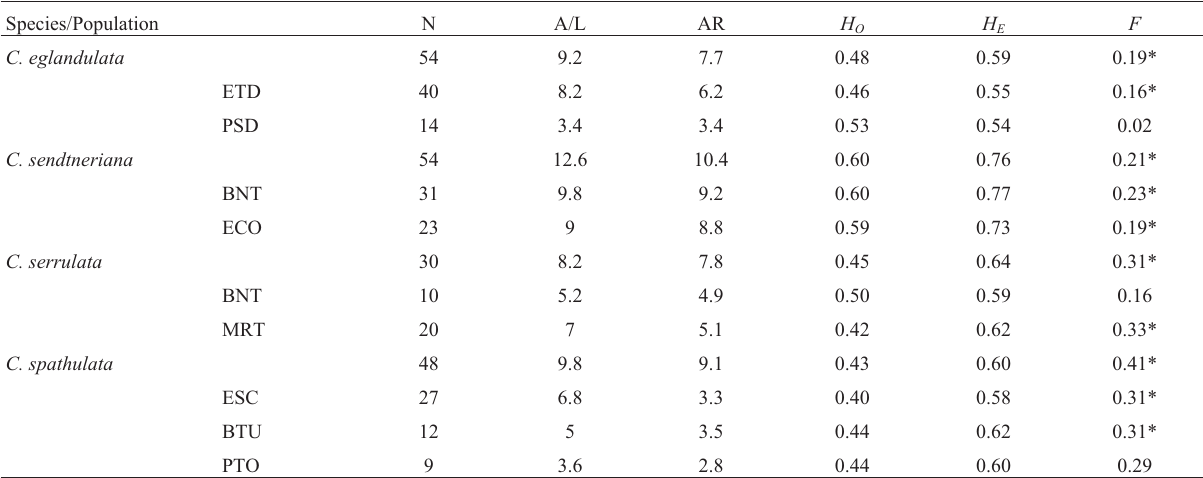
Table 4 - Genetic diversity and demographic indices for four Calibrachoa species based on nuclear microsatellites and populations .